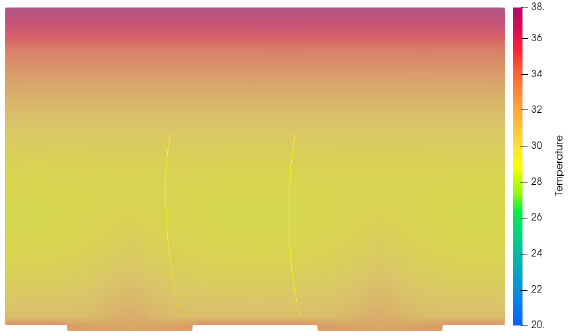
Figure 8. Heating of both surfaces during the day in the bridge deck, in spot under